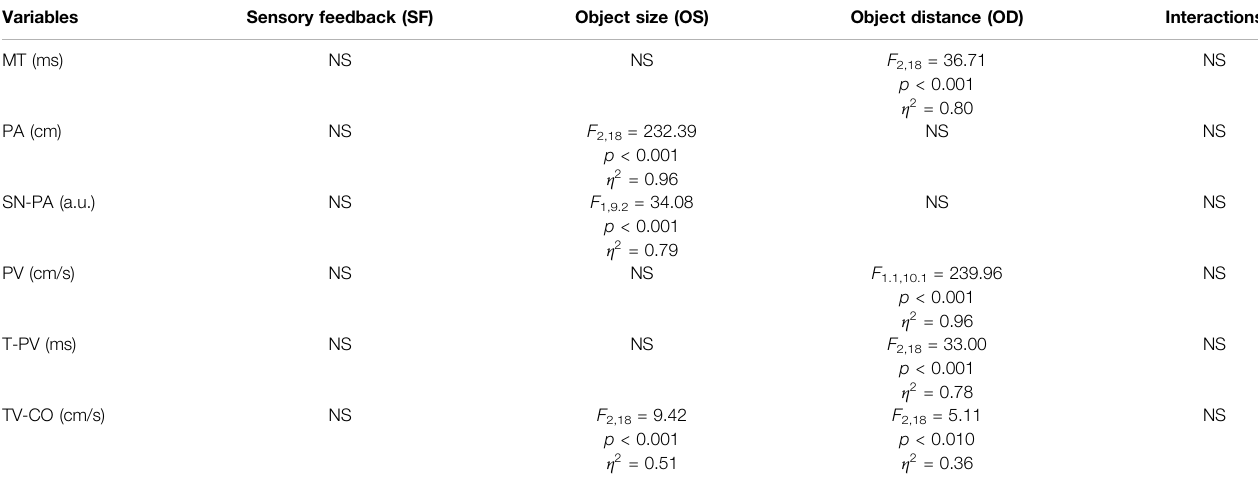
TABLE1| Outcomesof3 × 3 × 3rm-ANOVAsexaminingtheeffectsofsensoryfeedback(visual,auditory,andaudiovisual),objectsize(small,medium,andlarge),andobject distance (near, middle, and far) on each kinematic variable in Study 1. Variables